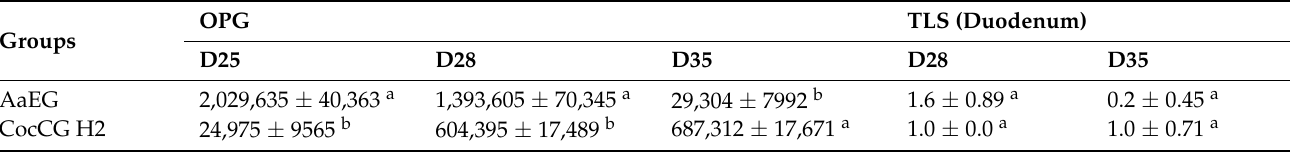
Table 3. Number of oocysts/g of feces (OPG) (average ± std. dev.) and total mean lesion score (TLS) (average ± std. dev.) in broiler chickens fed with the A. annua supplemented feed in comparison with broiler chickens fed with anticoccidial supplemented